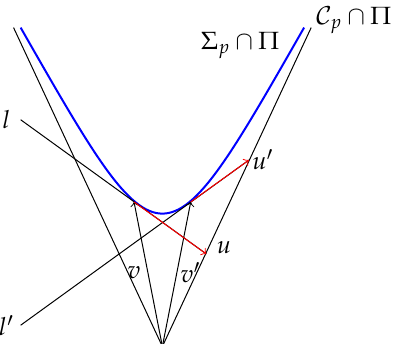
Figure 3. In the plane π spanned by the observers v , v (cid:48) , the tangent lines to Σ p in π , l and l (cid:48) differ. Then, if u ∈ S v and u (cid:48) ∈ S v (cid:48) , possibly, g v ( u , u ) (cid:54) = g v (cid:48) ( u (cid:48) , u (cid:48) ) . Therefore, the observers v and v (cid:48) measure different speeds of light in their common plane π